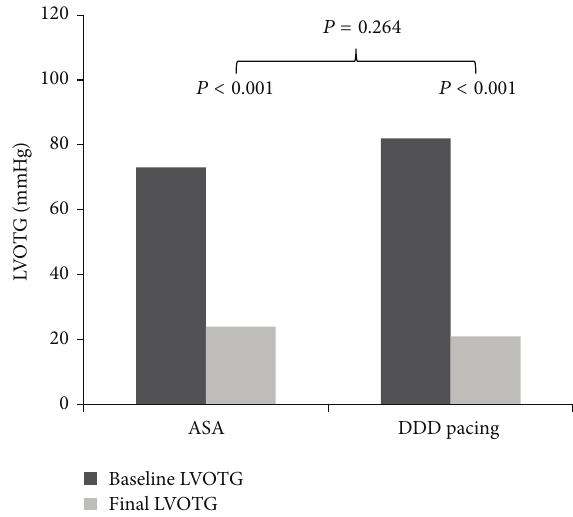
Figure 1: ASA—alcohol septal ablation, DDD pacing—dual cham- ber pacing, and LVOTG—left ventricle outflow tract gradient.